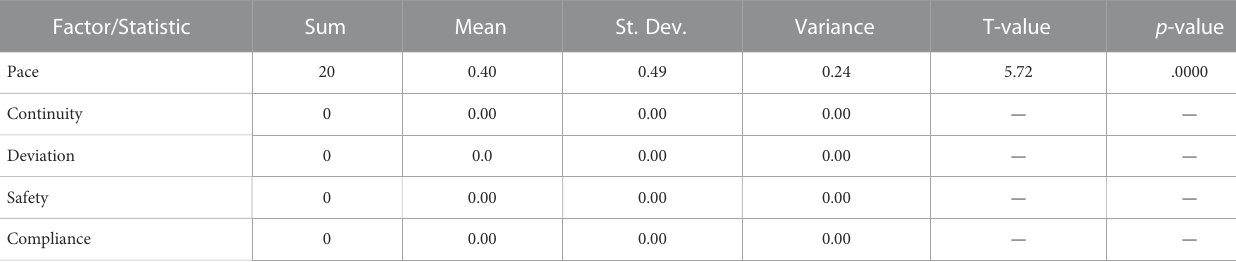
TABLE 8 Descriptive statistics of the performance factor in scenario 4: Bend.